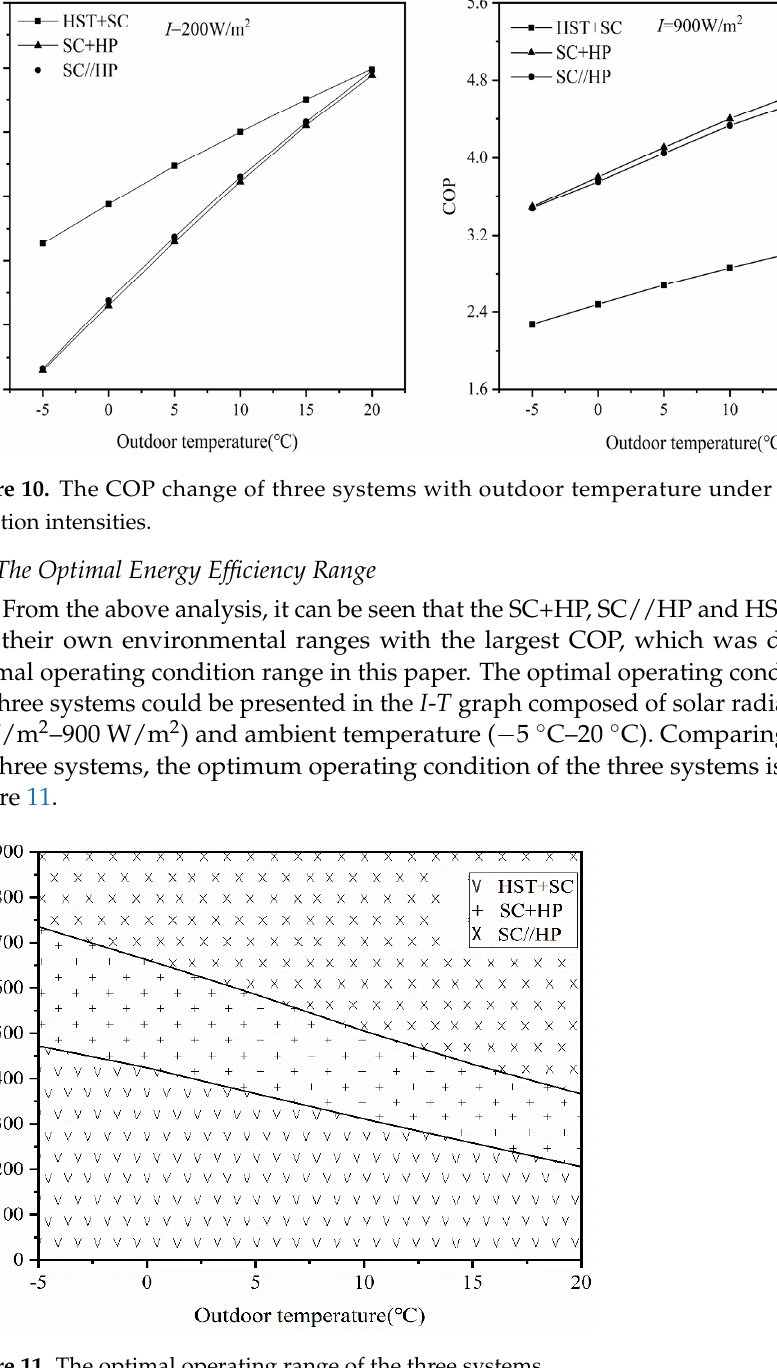
Figure 11. The optimal operating range of the three